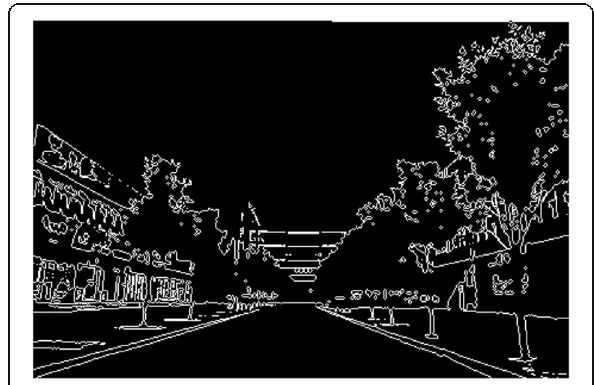
Fig. 5 Road edge detected by the Laplacian operator